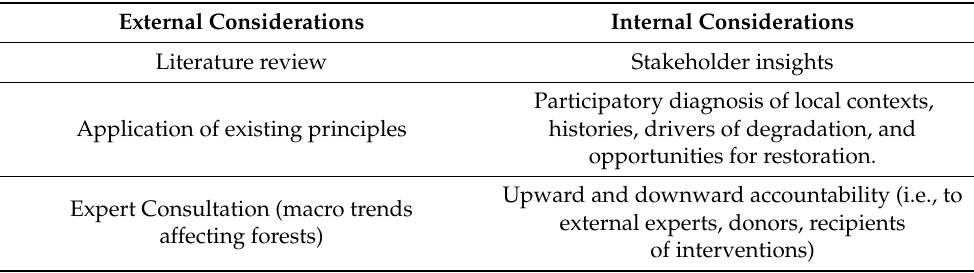
Table 1. Degradation and restoration assessment basic